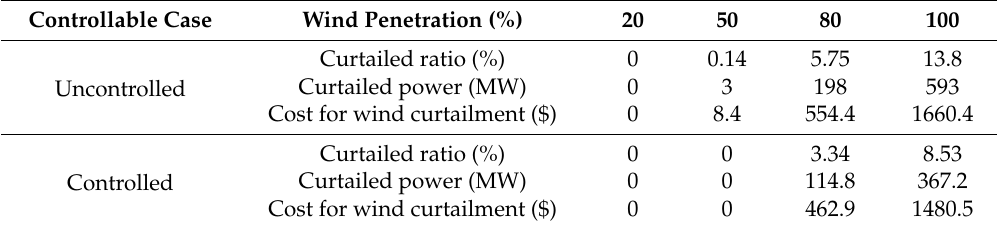
Table 3. Utilization ratio of wind power with different wind penetration